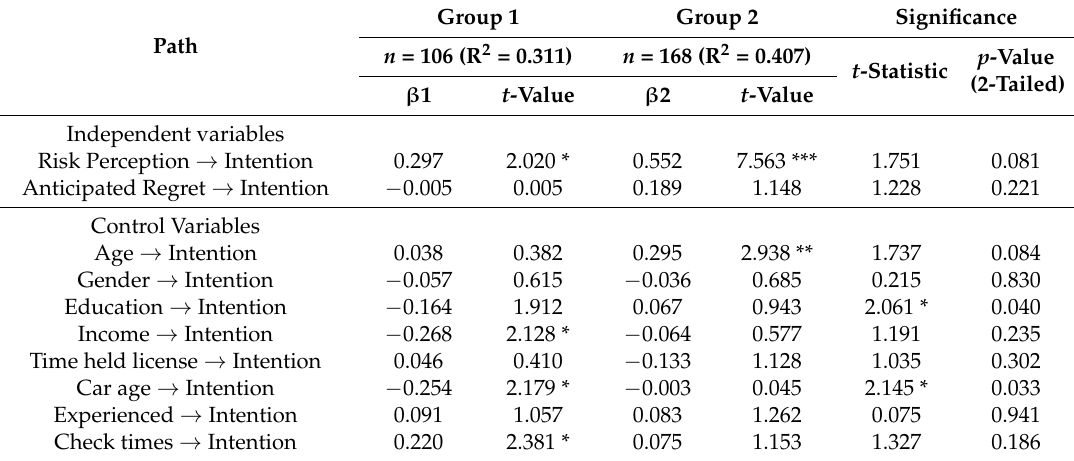
Table 6. Results structural model analysis.